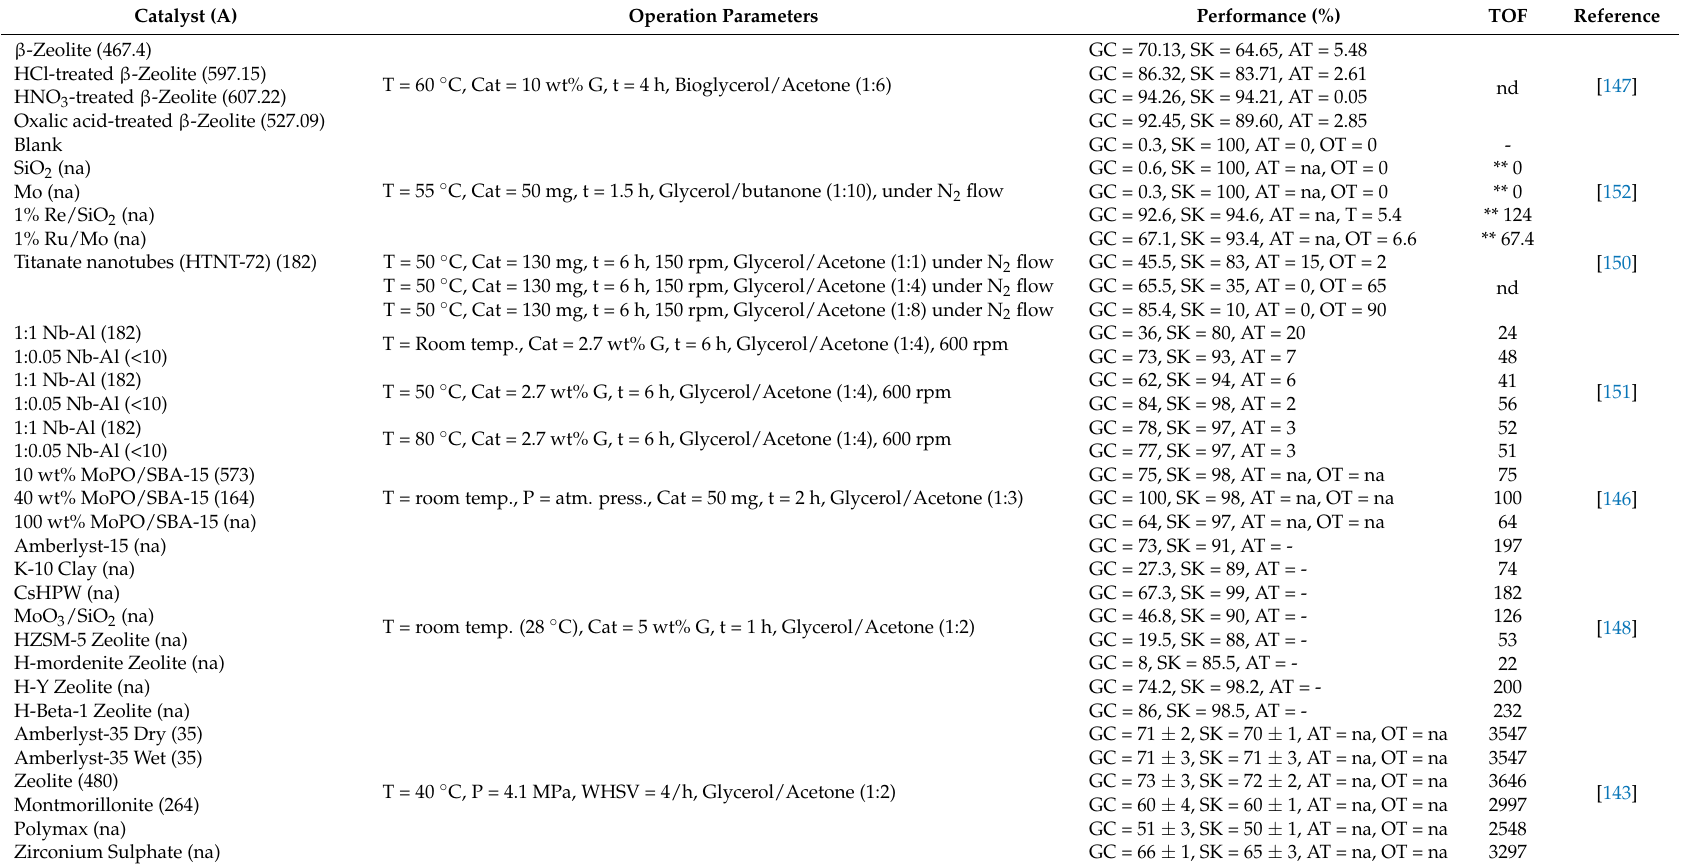
Table 10. Performance of some catalysts in the conversion of glycerol to solketal and acetal as reported in some